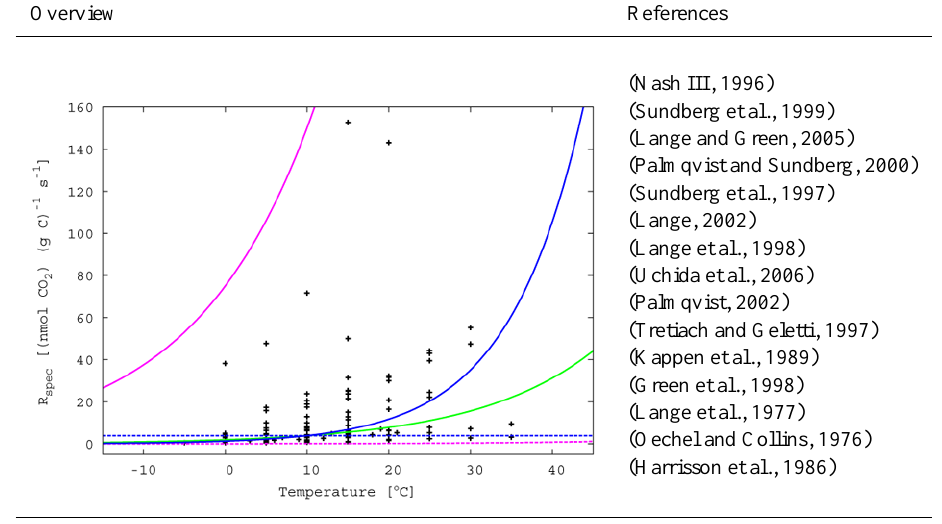
Fig. B8. Influence of reference maintenance respiration x R and Q 10 value of respiration x Q on specific respiration rate R spec . The green ref 10 line shows the response of respiration to temperature for values of x R and x Q , which are both in the middle of their respective ranges. ref 10 = 1 while the solid blue line corresponds The blue lines show the effect of the Q 10 value x Q : the dashed blue line corresponds to x Q 10 10 = 3. The magenta lines illustrate the effect of reference respiration rate x R to x Q at 10 ◦ C: the dashed magenta line corresponds to 10 ref − 1 s − 1 while the solid magenta line corresponds to x − 4 (mol CO − 1 s − 1 . The = 1 × 10 − 7 (molCO x R R ref = 1 . 5 × 10 2 )(kgC) 2 )(kgC) ref black data points are derived from the studies listed in the right